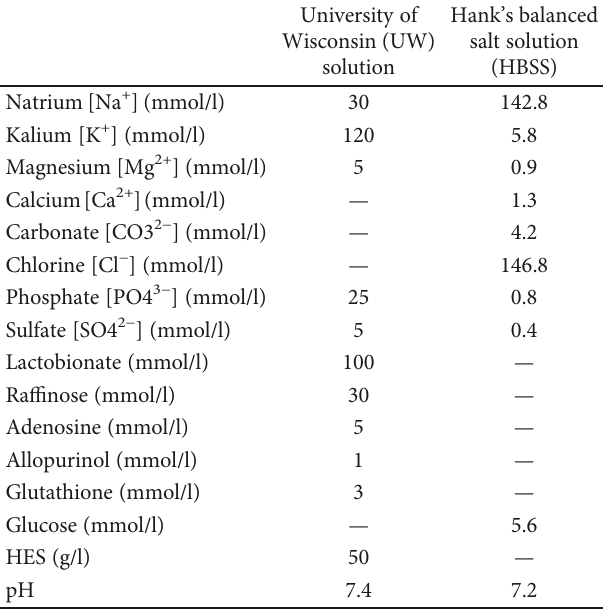
Figure 4: Phenotype and di ff erentiation potential of ADSCs after preservation for 16h in HBSS or UW solution. Morphological appearance of ADSCs (passage 2) in the HBSS- (a, left panel) and UW solution-preserved groups (c, left panel). Cell surface markers of ADSCs (passage 2) preserved in HBSS (a, right panels) or UW solution (c, right panels) by fl ow cytometry. Representative images of di ff erentiated adipocytes from ADSCs preserved in HBSS (b, left panel) and UW solution (d, left panel), and di ff erentiated osteocytes from ADSCs preserved in HBSS (b, right panel) and UW solution (d, right panel). Table 1: The speci fi c composition of UW solution and